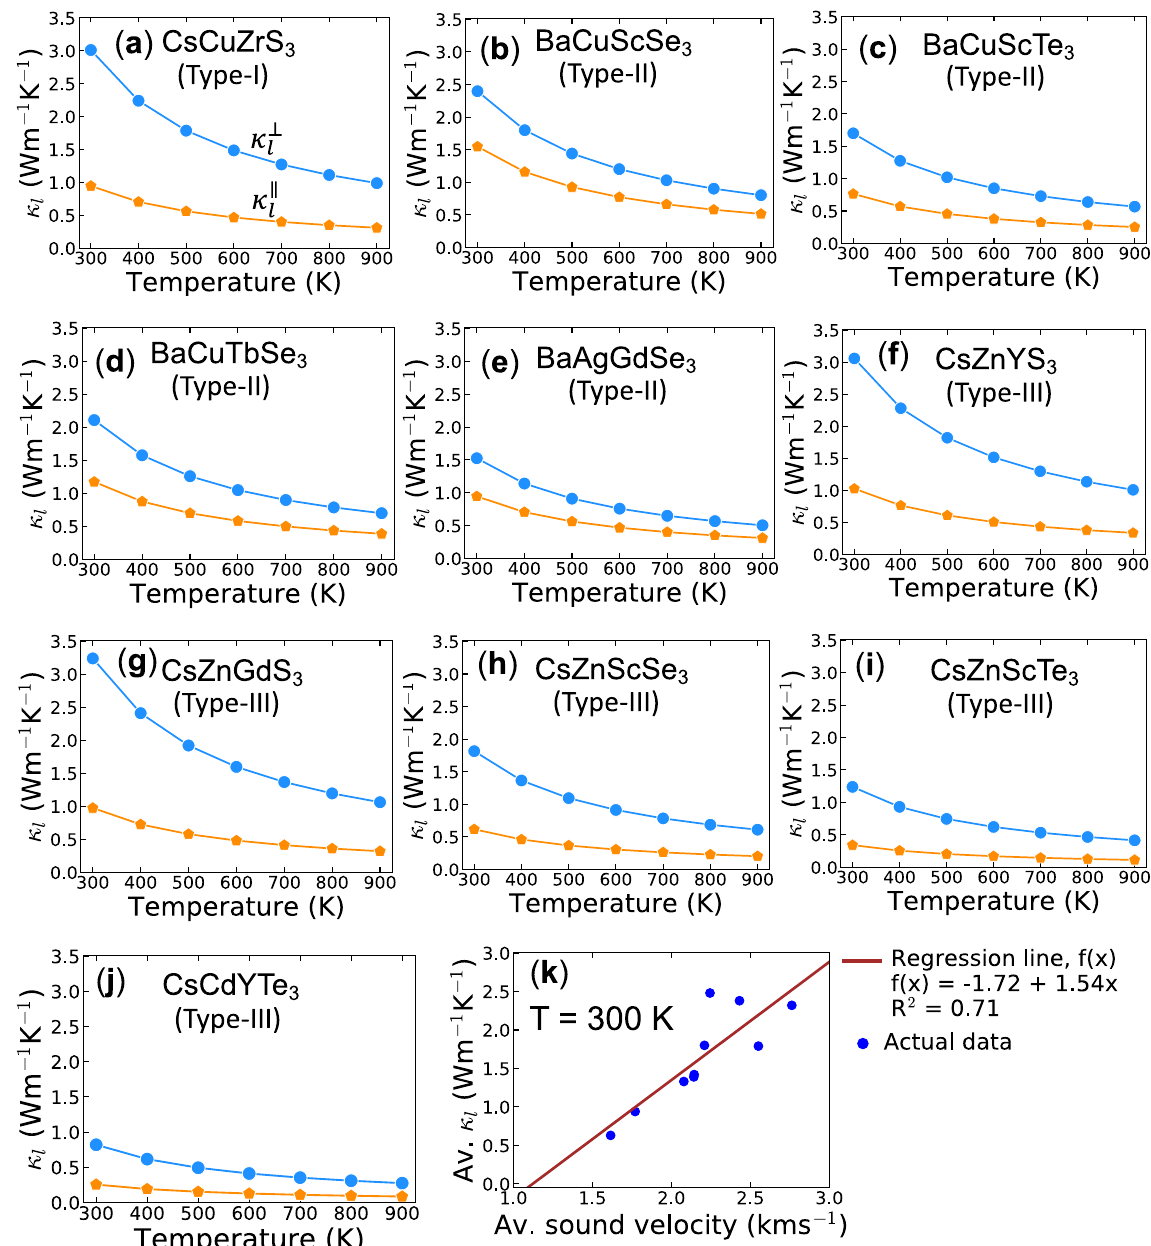
Fig. 5 Lattice thermal transport properties of the AMM ′ Q 3 compounds. a – j The calculated temperature-dependent lattice thermal conductivity ( κ l ) of ten predicted stable AMM ′ Q 3 compound which are non-magnetic and semiconducting. κ ? pentagon) are the two components of κ l that are perpendicular and parallel to the stacking directions in the crystal structure, respectively. k Predictive statistical model of κ l . A linear regression model, f ( x ), is fi tted to the average (Av.) sound velocity vs average κ l data (at 300 K) of those ten compounds, which is used to predict κ l of other AMM ′ Q 3 compounds based on their average speed of